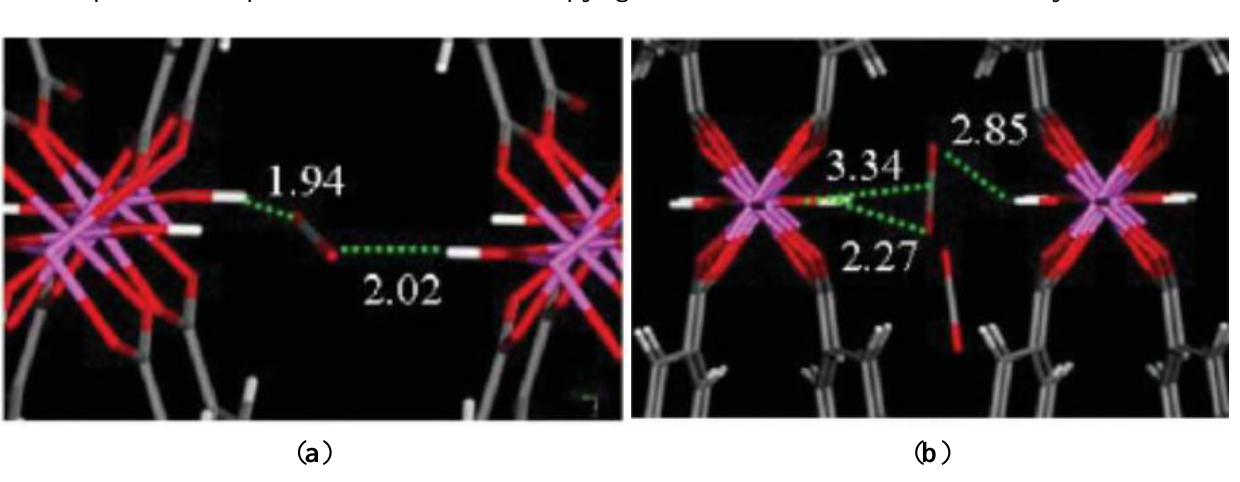
Figure 22. Simulation of CO arrangement of the adsorption on MIL-53(Al). ( a ) at the 2 initial stage of loading in MIL-53 np (Al); ( b ) at the high stage of loading in MIL-53 lp (Al). Reprinted with permission from [130]. Copyright 2008 American Chemical